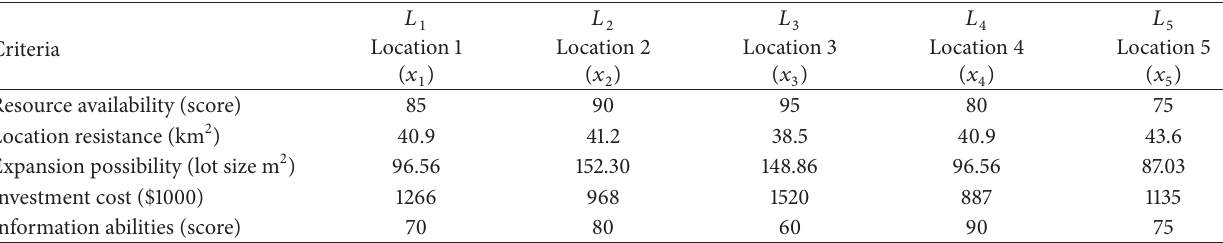
Table 4: Location selection parameters.